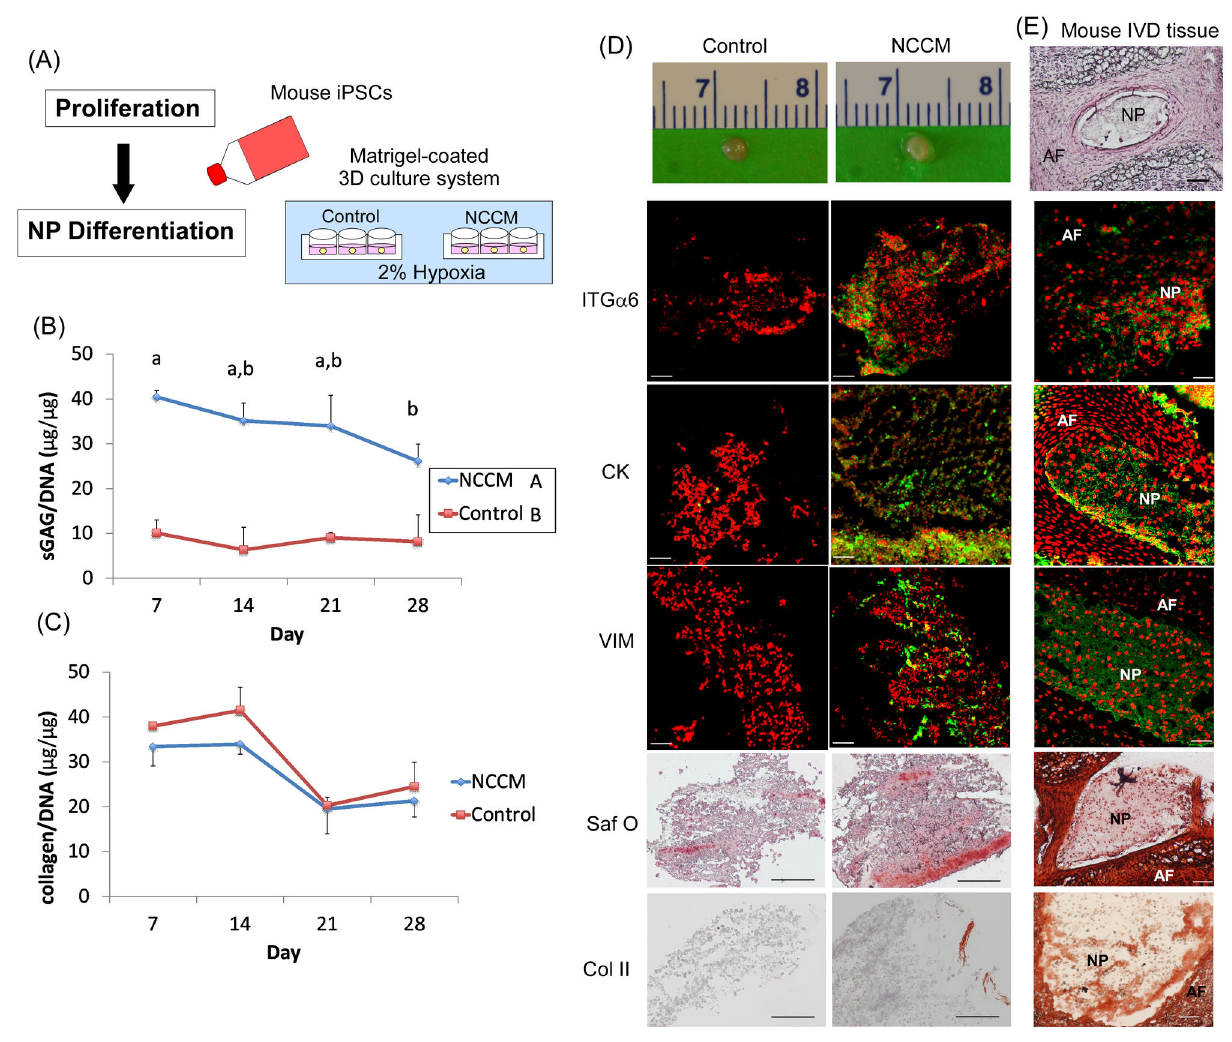
Figure 5. Differentiation of iPSCs under hypoxic conditions in vitro . (A) General experimental overview. (B) Sulfated- glycosaminoglycan content normalized to DNA content (sGAG/DNA) in cell constructs (results shown as mean+SD, n=3 samples). Significant effects of treatment and time were detected using a two-way ANOVA and Tukey’s HSD (p<0.05). Treatment and time points denoted by different letters were found to be significantly different: uppercase letters for treatment; lowercase letters for time. (C) Total collagen content normalized to DNA (collagen/DNA) in cell constructs (results shown as mean+SD or –SD, n=3 samples). No significant effects of treatment on collagen production were detected via two-way ANOVA and Tukey’s HSD (p>0.05). (D) Cell constructs extracted from Transwelsl at the end of the culture (day 28) and representative images of histology and immunostaining revealed matrix accumulation (Saf O for glycosaminoglycan and type II collagen, Col II; Scale bar: 100 µm) and expression of NP- associated markers (vimentin, VIM; cytokeratin 5/8, CK and integrin α6, ITGα6) in cell constructs at days 28. Scale bar: 50 µm. NCCM: notochordal cell conditioned medium. (E) Representative images of histology (H and E) and immunostaining for above mentioned NP-associated markers and matrix proteins in the immature mouse IVD (1 month-old) tissue control (AF: anulus fibrosus; NP: nucleus